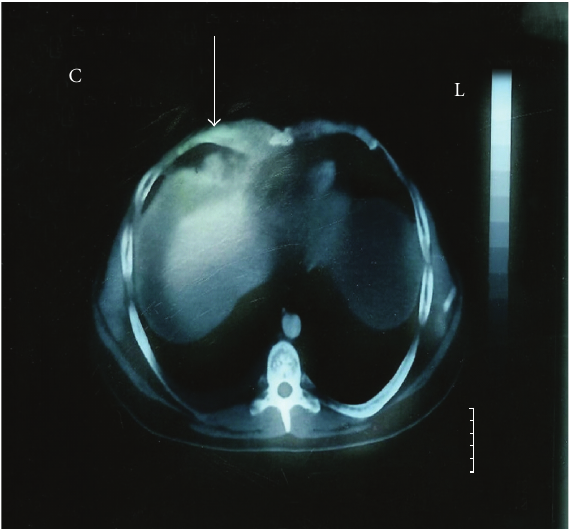
Figure 4: Axial stir (short-tau-invesion-recovery) MR image of the upper thorax demonstrates a lesion located in the right part of the anterior thoracic wall and shows increased inhomogeneous signal intensity. The lesion has irregular contour, involving the major pectoralis muscle. Inside the lesion, a node is